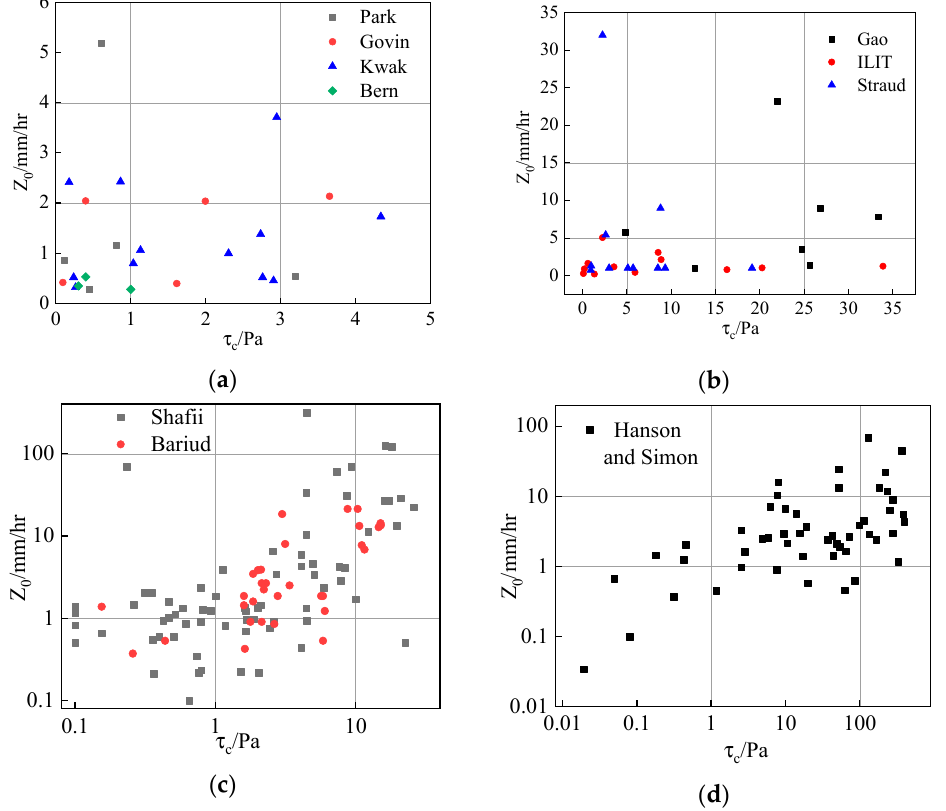
Figure 6. The erodibility coefficient ( Z 0 ) as a function of critical flow shear stress ( τ c ) under identical experimental conditions: Sub-dataset 1 ( a ), Sub-dataset 2 ( b ), Sub-dataset 3 ( c ), and Sub-dataset 4 ( d